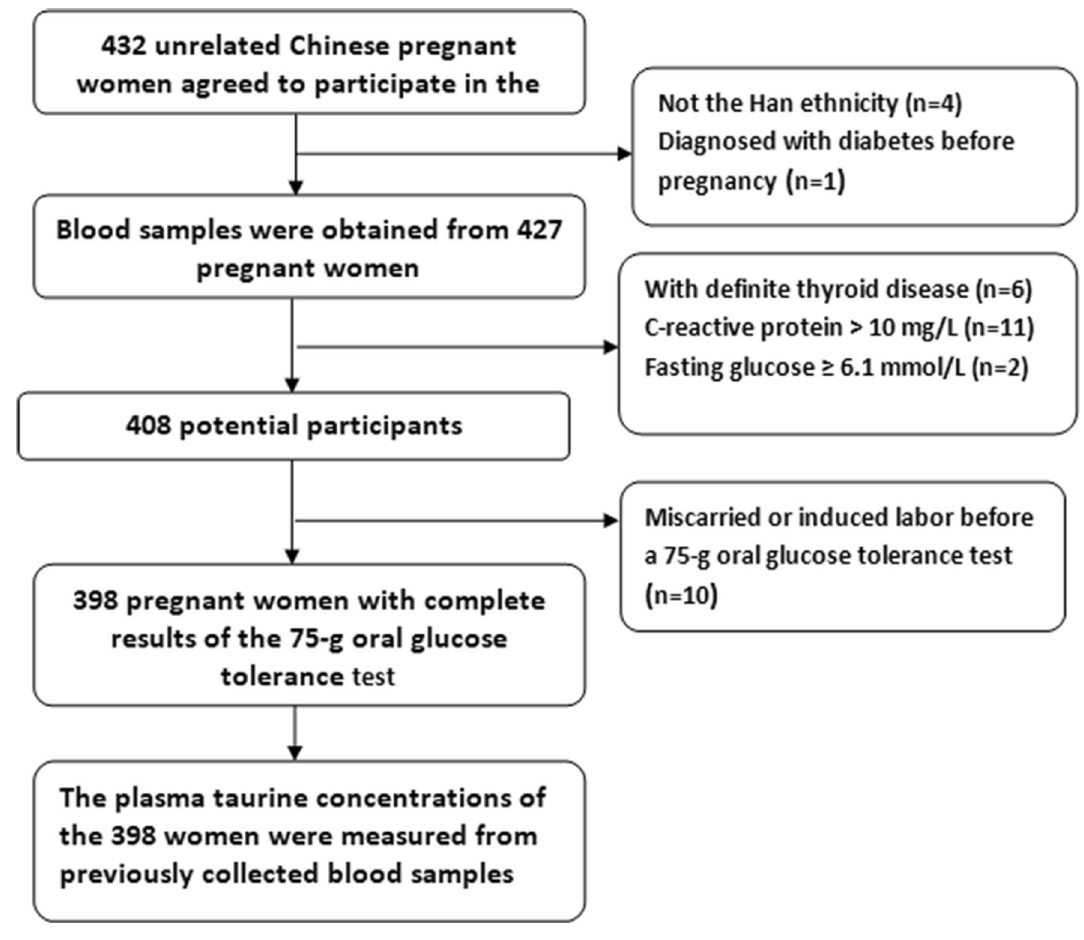
Figure 3. Participant